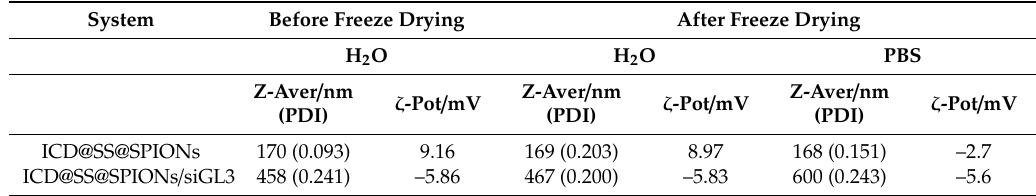
Table 3. Size and ζ potential measured by DLS of ICD@SPIONs (uncrosslinked), ICD@SS@SPIONs (crosslinked) and ICD@SS@SPIONs / siRNA nanoparticles, before (black coloured data) and after (grey coloured data) freeze drying process. PDI values are reported as data